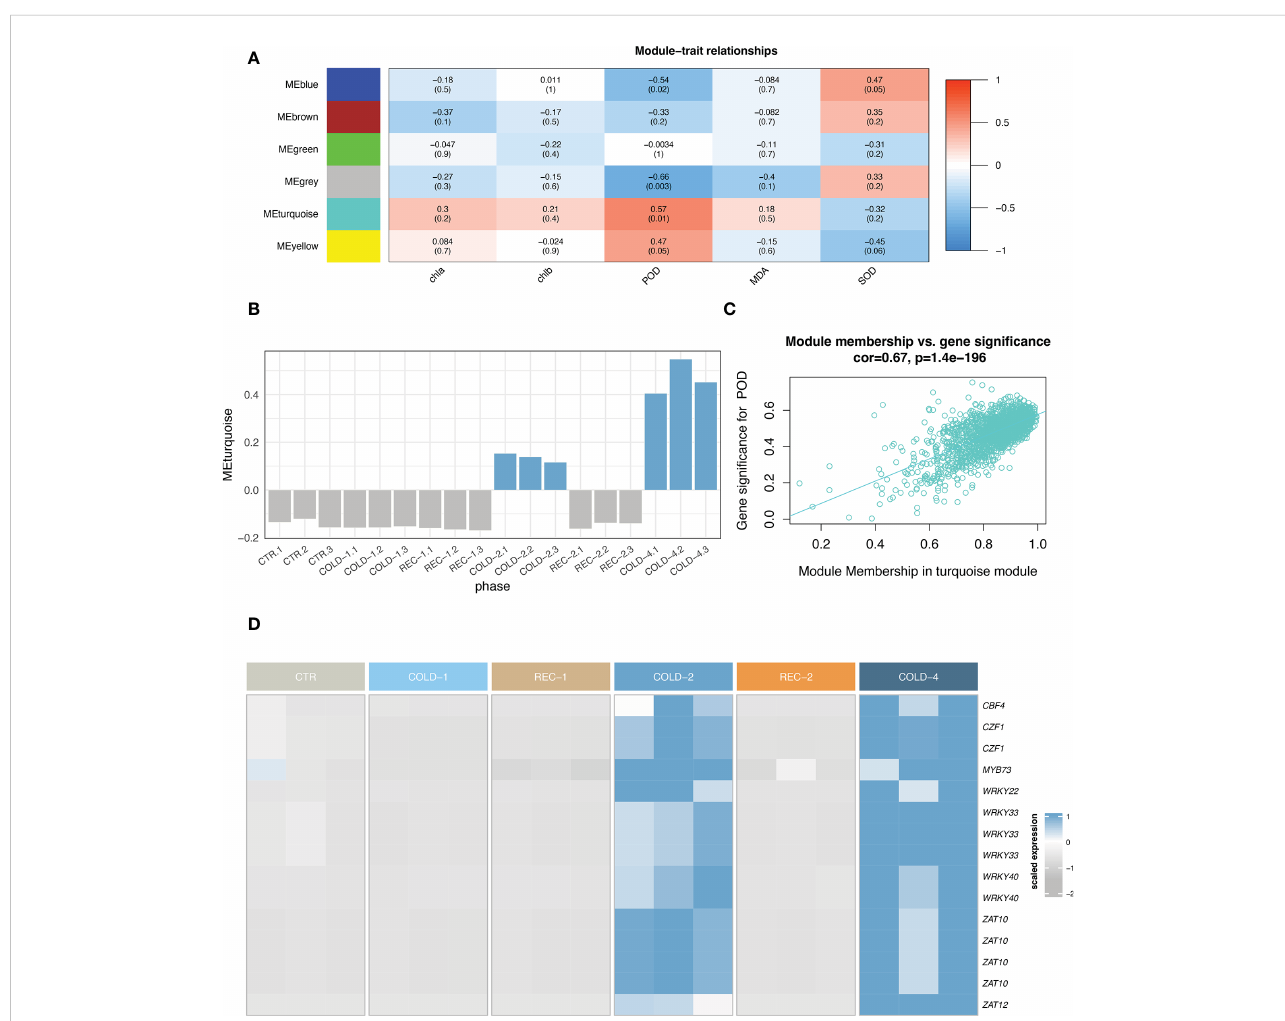
FIGURE 4 Co-expression network of DEGs. (A) Heatmap of the module-trait relationships. The numbers in a cell were the Pearson correlation coef fi cient between the module eigengene and the trait, and the numbers in the bracket showed the p values. The fi gure was color-coded by correlation coef fi cient. MDA, malondialdehyde; SOD, superoxide dismutase; POD, peroxidase; chla, chlorophyll a content; chlb, chlorophyll b content. (B) The eigengene expression pro fi le in Module turquoise. (C) The gene signi fi cance of POD against turquoise module membership. (D) The heatmap of representative hub- transcription